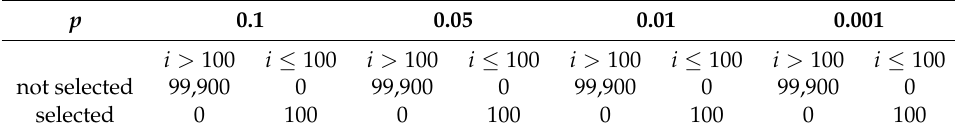
Table 5. Confusion matrices when PCA-based unsupervised FE is applied to the synthetic data. p is the threshold p -value. Features are selected when adjusted p -values less than the threshold p -values (cid:109) (cid:16)(cid:108) (cid:109) (cid:17) (cid:108) j k + 3 . Averaged over 100 independent trials. are associated with them. 3 3 p 0.1 0.05 0.01